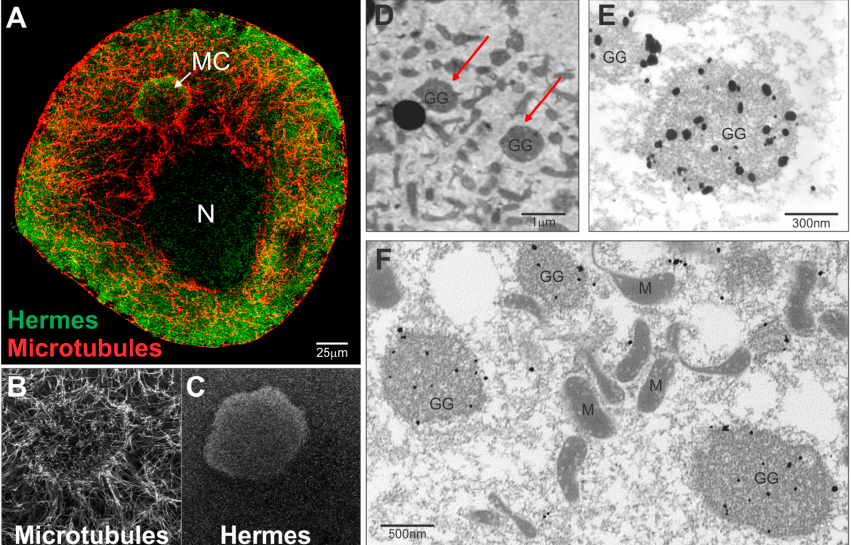
Figure 1. Hermes/Rbpms protein and nanos RNA localize within germinal granules unique to germ plasm. Stage I oocyte. ( A ) Immunofluorescence (IF) and confocal microscopy showing Hermes/Rbpms protein ( green ) is ubiquitous in stage I oocyte including the mitochondrial cloud (MC), nucleus (N) and ooplasm; microtubules ( red ). Enlarged image from ( A ) showing microtubule organization around MC ( B ) and Hermes/Rbpms ( C ); Note how Hermes/Rbpms is enriched within the germ plasm region of the MC; ( D ) Electron micrograph showing a region of germ plasm within the MC of stage I oocyte. Red arrows indicate two germinal granules; ( E ) Nanos RNA is localized within germinal granules in stage I oocytes as is Hermes/Rbpms protein ( F ). Electron microscopy in situ hybridization with antisense Digoxigenin labeled nanos RNA was visualized with nanogold conjugated anti-Dig antibody and silver enhancement. Electron microscopy immunostaining with Hermes/Rbpms polyclonal antibody [49], anti-rabbit nanogold conjugated secondary antibody and silver enhancement. Scale bars are as indicated. GG (germinal granules); M (mitochondria); N (nucleus).